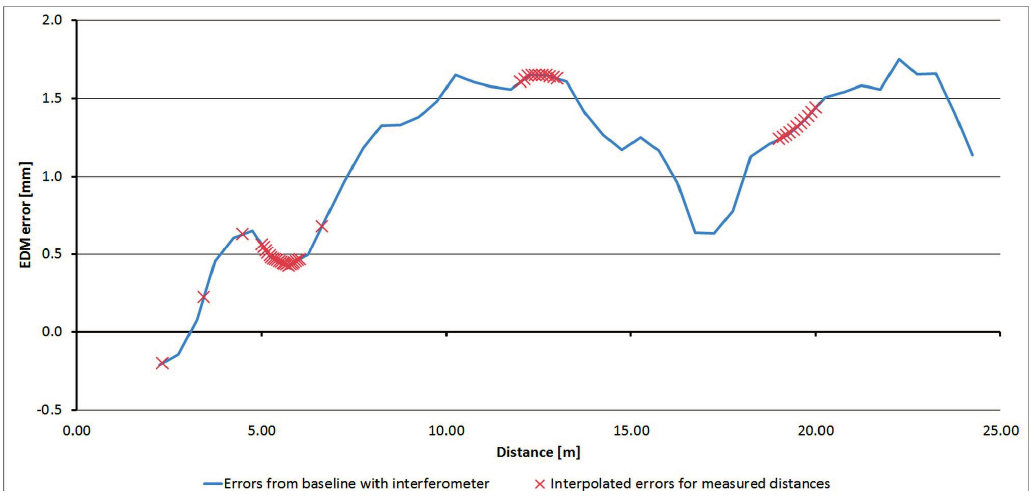
Figure 35. Interpolated corrections of the measured distances–Trimble S6.